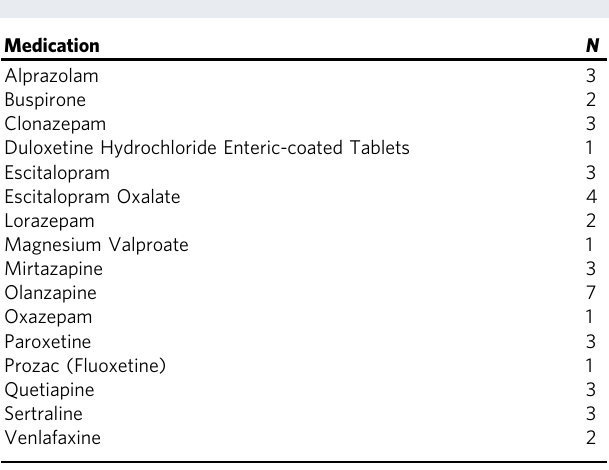
Table 2 Medication list.